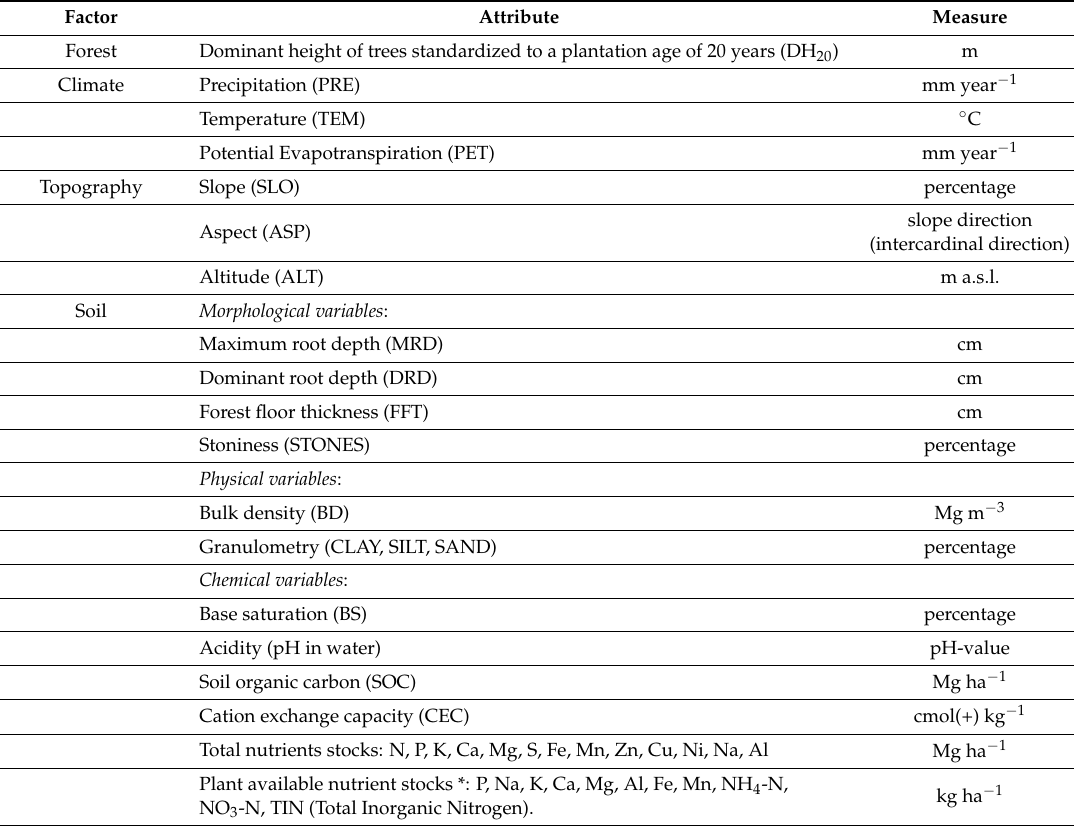
Table 2. Set of environmental attributes for the forest site classification in this